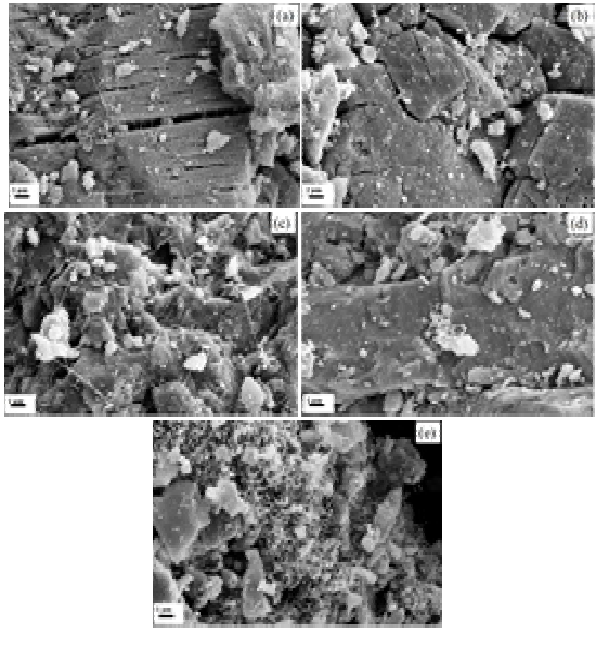
Fig. 3 . SEM images of (a) Zn